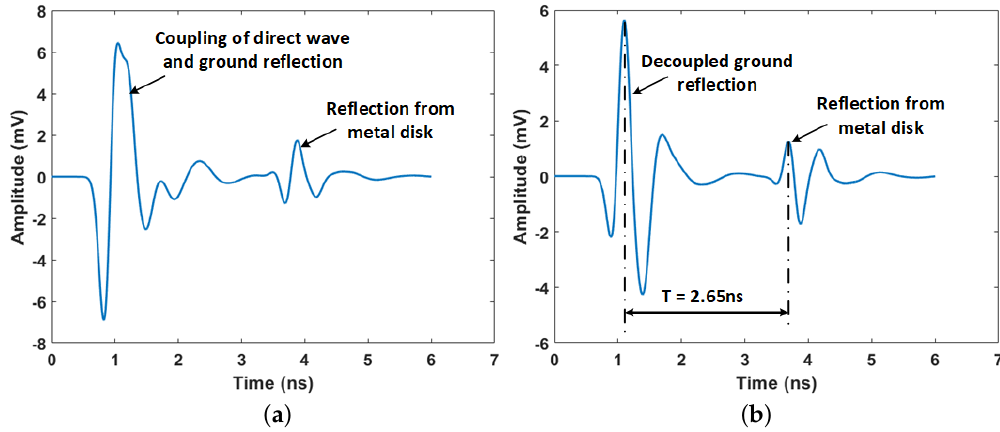
Figure 7. GPR signal for metal disk of a radius of 3 cm buried at 24 cm in dry soil, ( a ) Raw GPR signal with coupled direct wave and ground reflection; ( b ) GPR signal after subtraction of the GPR antenna’s system